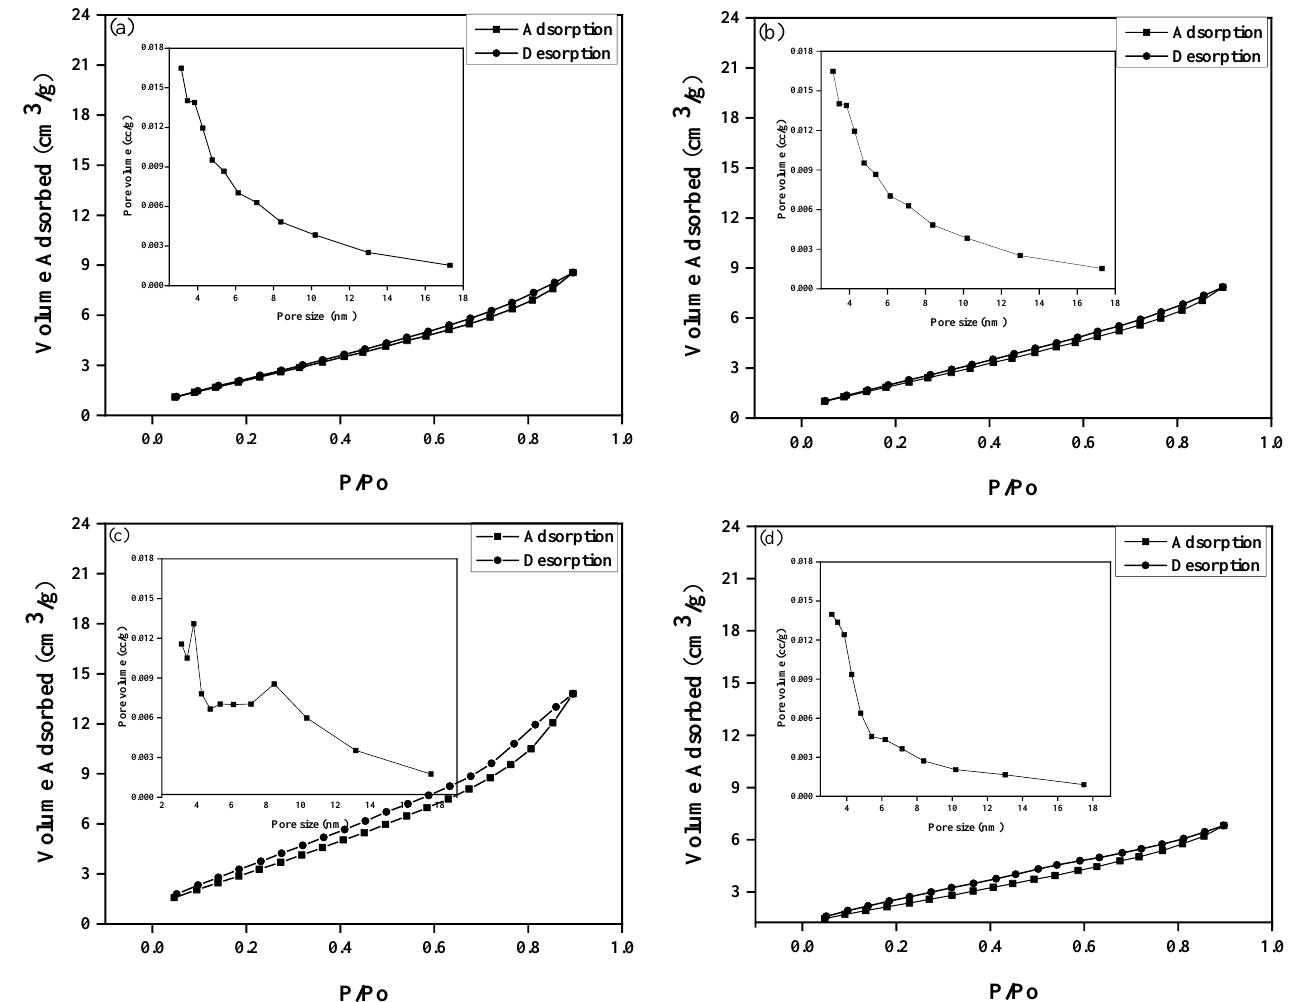
Figure 6. Adsorption and desorption curves of Mg 2 SiO 4 powders calcined at the temperatures of ( a ) 850, ( b ) 900, ( c ) 950, and ( d ) 1000 ◦ C. The inserts are their corresponding pore size distributions. Additionally, the BET measurements indicated the specific surface areas of 16.3 ± 4.0, 18.9 ± 5.4, 21.4 ± 5.1, and 16.8 ± 5.1 m 2 /g for 850, 900, 950, and 1000 ◦ C calcined powders, respectively. From the data, the specific surface area increased with the calcination temperature from 850 to 950 ◦ C, but the value of the specific surface area declined rapidly at the temperature of 1000 ◦ C. Figure 7 indicates the typical XEDS spectra of the Mg 2 SiO 4 powders calcined from 850 to 1000 ◦ C; C-K α and Pt-M α peaks were obtained from the environment and surface conductive coating (to avoid sample charging), respectively; the main XEDS peaks of O-K α (0.53 keV), Mg-K α (1.25 keV), and Si-K α (1.74 keV) suggest that Mg 2 SiO 4 powders contained O, Mg, and Si elements. Furthermore, the 850 ◦ C calcined powder yielded 21.59 ± 0.67% Mg and 10.43 ± 0.45% Si. Similar results were acquired for the 900, 950, and 1000 ◦ C calcined Mg 2 SiO 4 powders (21.28 ± 1.41% Mg and 10.14 ± 1.15% Si in the 900 ◦ C case, 21.58 ± 0.69% Mg and 10.09 ± 1.28% Si in the 950 ◦ C case, and 20.01 ± 0.86% Mg and 10.62 ± 1.87% Si in the 1000 ◦ C case). It should be noted that no oxygen information is provided because the energy of O-K α is too low to be identified precisely using XEDS.